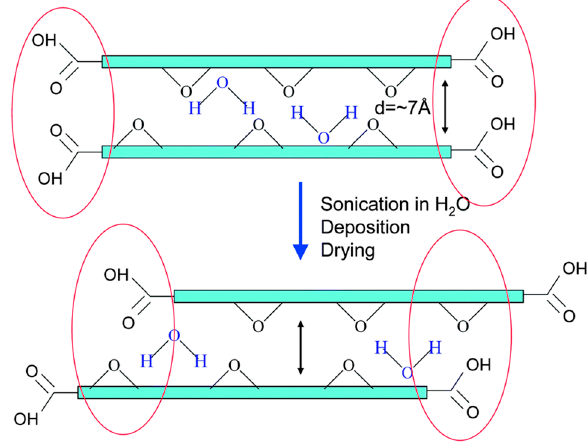
Figure 15. Schematic showing the arrangement of graphene oxide flakes in powder and membranes. Various combinations of functional groups govern the access to the interlayers.